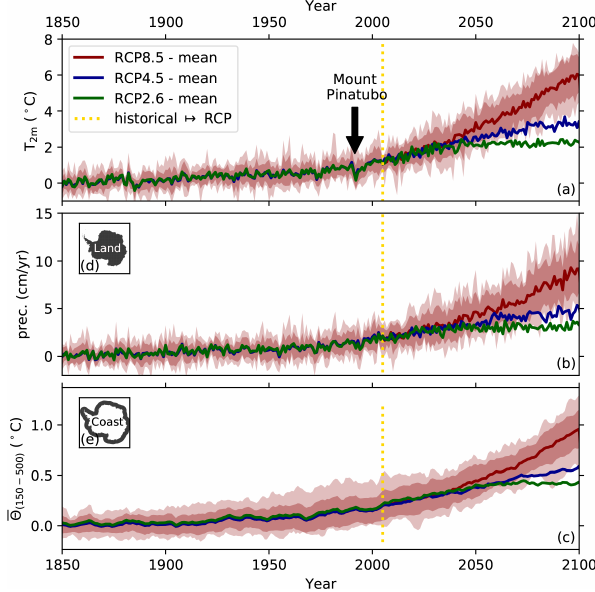
Figure 3. Spatial mean of the (a) 2m air temperature and (b) to- tal precipitation anomalies on Antarctica (d) . Spatial mean of the (c) potential ocean temperature that is averaged over the depth in- terval from 150 to 500m in the coastal zone surrounding Antarc- tica. In subfigure (e) , the dark region defines the coastal zone. The CMIP5 data set mean values are shown for the scenarios according to the legend in panel (a) . The dark-red band highlights the 1 σ stan- dard deviation (66%), and the light-red band shows the full range covered by all CMIP5 models for RCP8.5 only. The vertical golden line marks the transition from the historical forcing to the RCP. The distinct air temperature jump during the historical period in 1991 marks the Mount Pinatubo volcanic eruption. The contours of the Antarctic continent (d) follow the outer edges defined by the data set of Fretwell et al. (2013), whereas the coastal strip (e) is an ex- tension into the sea with smoothed northern edges (typical width of about